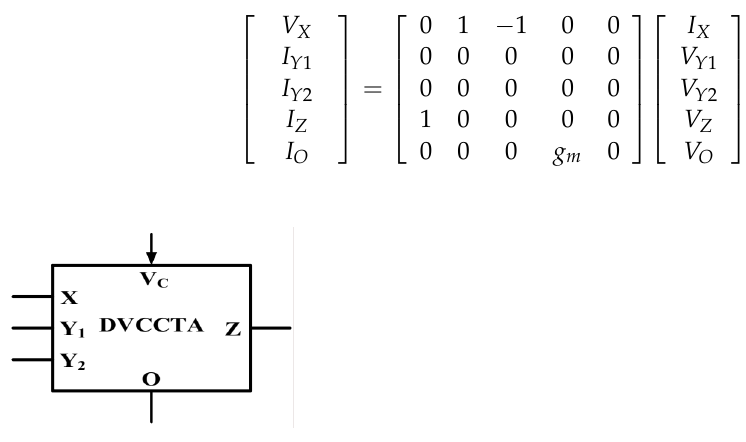
Figure 1. Symbol of